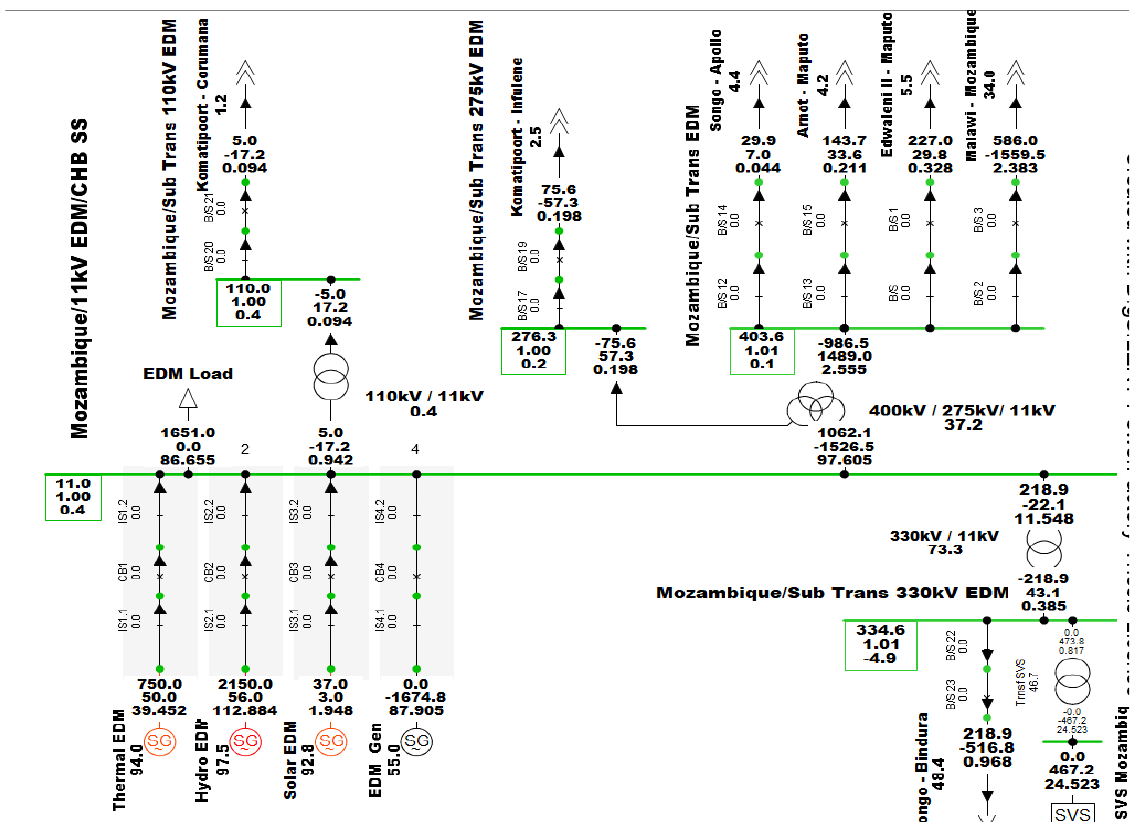
Figure 13. Mozambique power utility with the static var system.